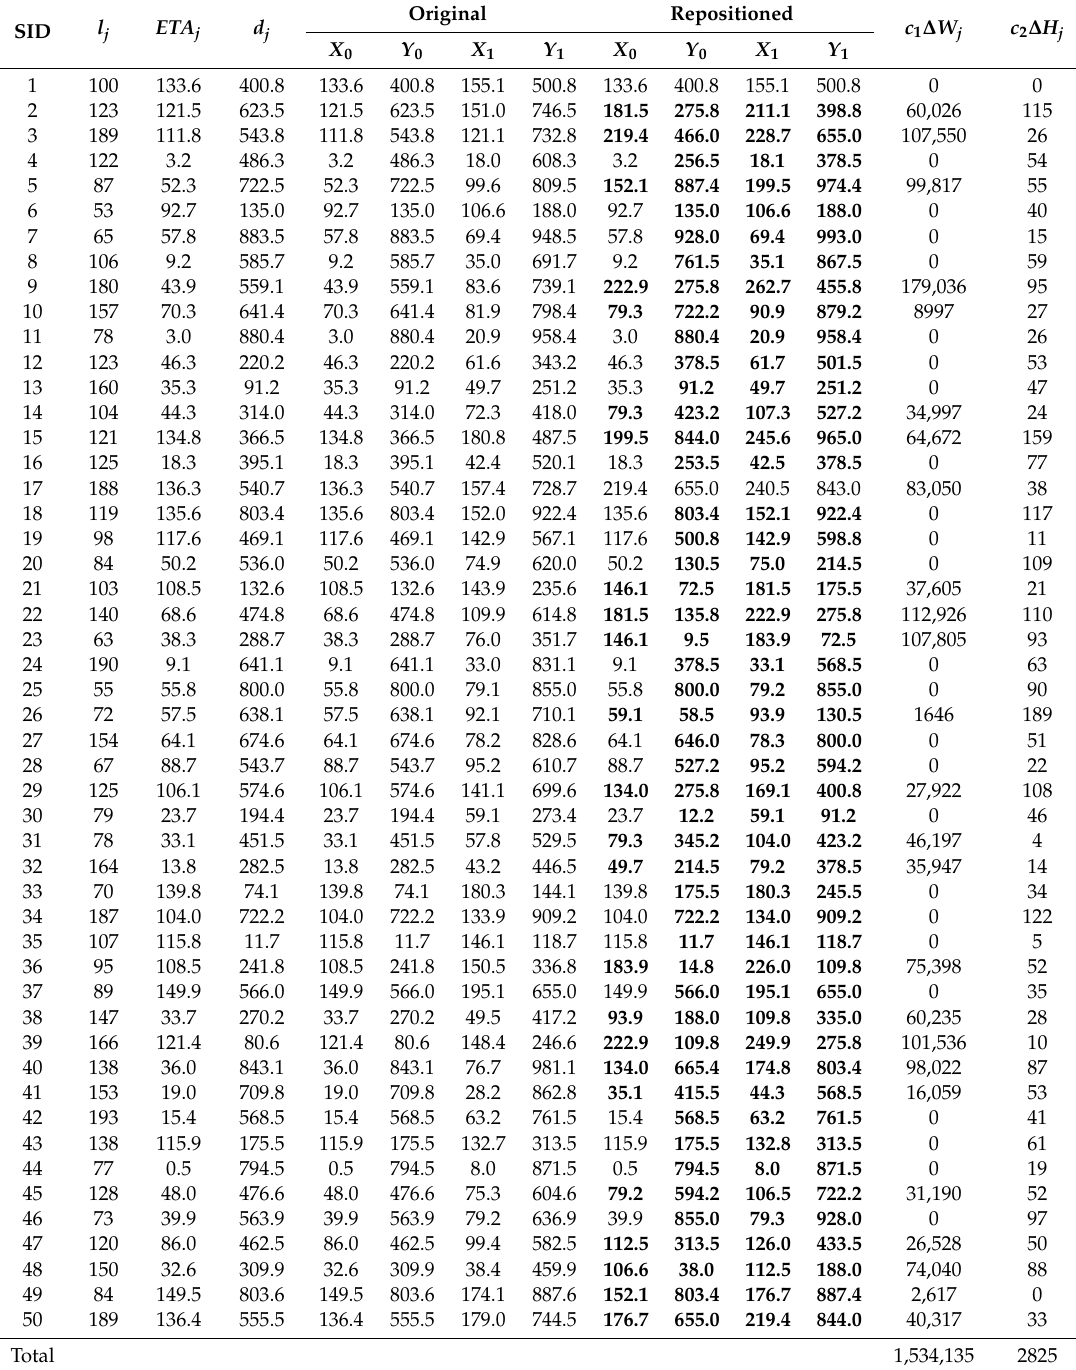
Table 3. The ship data obtained from a large-sized experiment ( N =